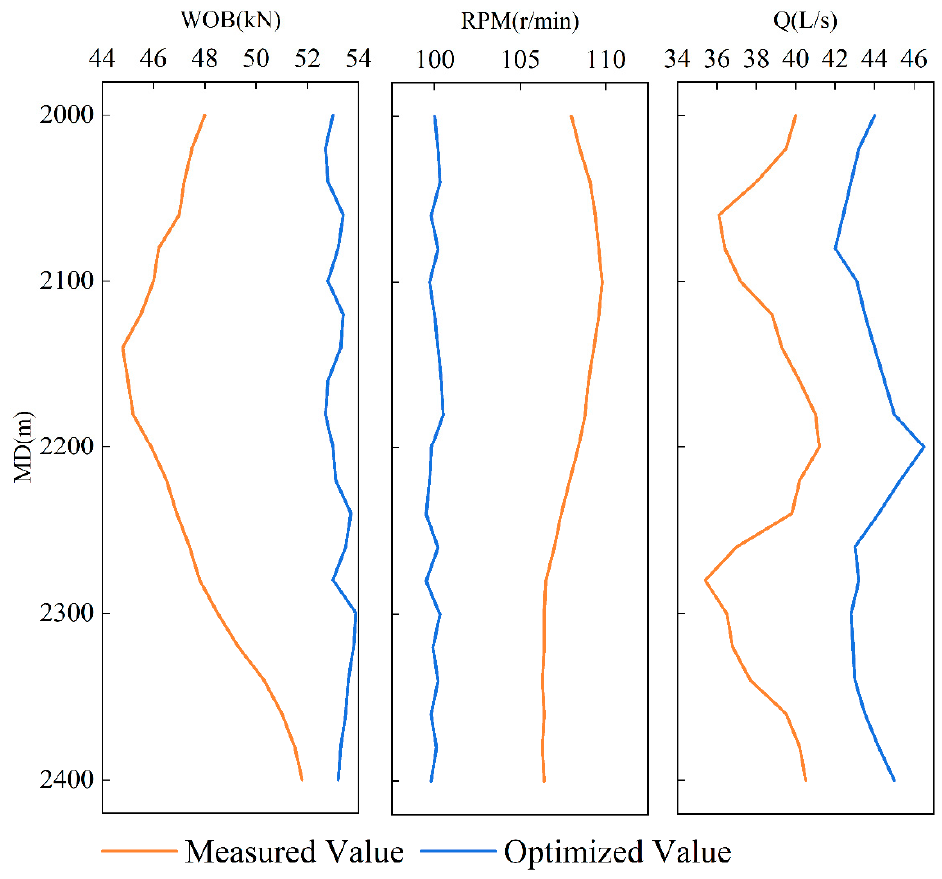
Figure 3. Comparison of WOB, RPM, and Q results before and after optimization.